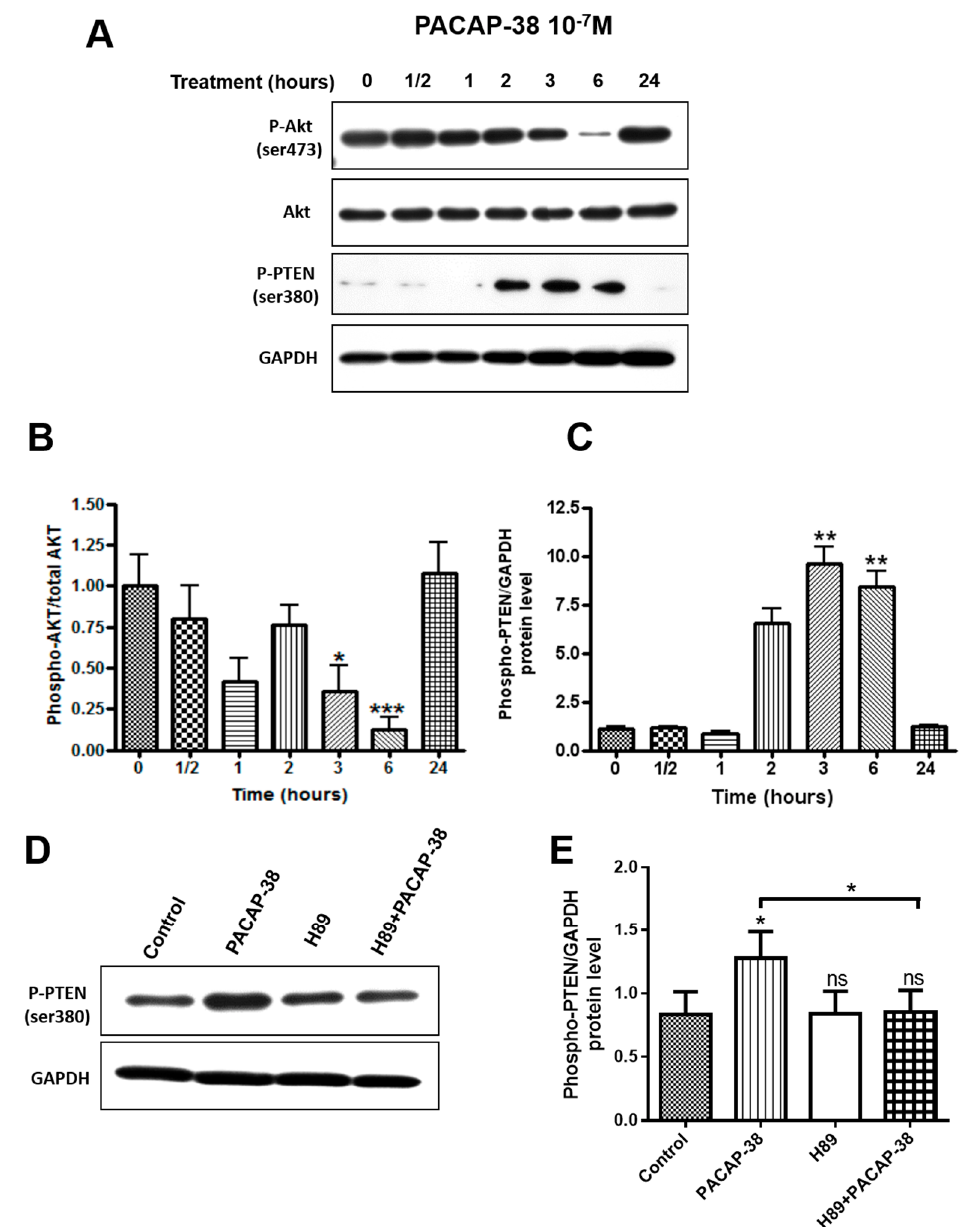
Figure 5. Effect of PACAP-38 on the phosphorylation of Akt and PTEN in C6 cells. Effect of the H89 PKA inhibitor on PACAP638 induced inhibition of PTEN phosphorylation. ( A , B , C ) Cells were treated with 10 -7 M PACAP-38 for the indicated times. Total cell lysates were analyzed by immunoblotting (WB) with antibodies recognizing total Akt, phosphorylated Akt, phosphorylated PTEN or GAPDH. ( A ) corresponds to a representative WB experiment. ( B , C ) Cumulative data from three independent experiments after quantification by densitometry. Data were normalized by attributing a value of 1 for the control experiment. ( D , E ) Cells were treated for 3 h with 10 -7 M PACAP-38, in the presence or not of 1 µ M H89. ( D ) corresponds to a representative WB experiment. ( E ) Cumulative data from three independent experiments after quantification by densitometry. Quantification data are the mean ± SD. Data were analyzed using the Kruskal–Wallis test and Dunn’s post hoc test (* p < 0.05, ** p < 0.01, and *** p < 0.001, ns: not significant).